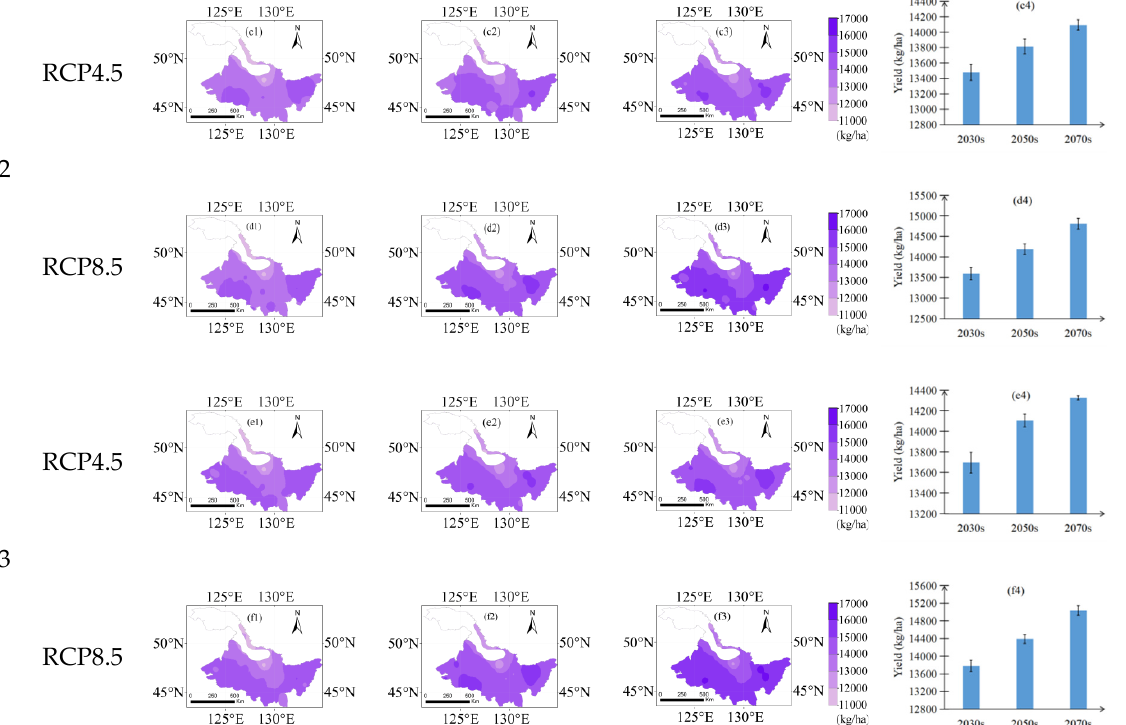
Figure 8. Spatial and temporal distribution of maize yield for the multi-GCM ensemble under different irrigation schedules (( a1 – a4 , b1 – b4 ) W1,( c1 – c4 , d1 – d4 ) W2,( e1 – e4 , f1 – f4 ) W3) in the 2030s, 2050s, and 2070s with two RCPs.